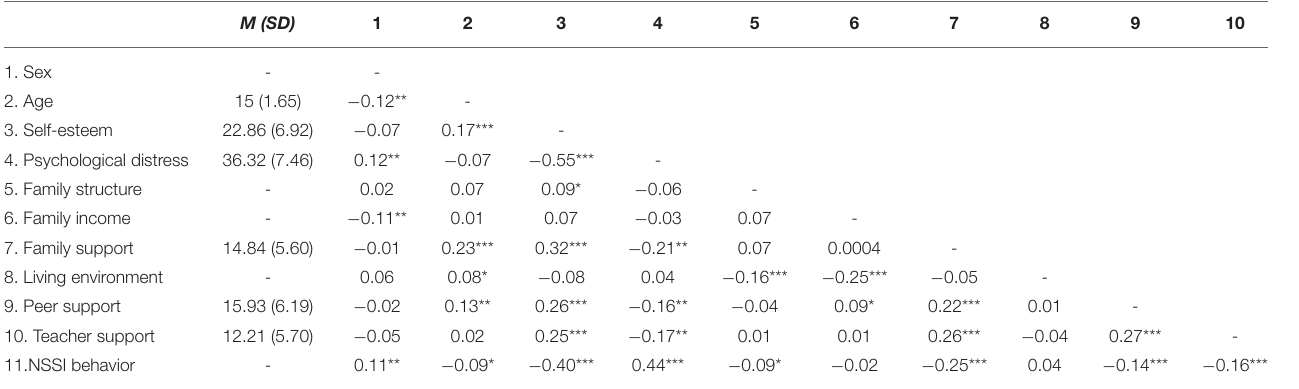
TABLE 1 | Descriptive statistics and correlations among study variables ( N =